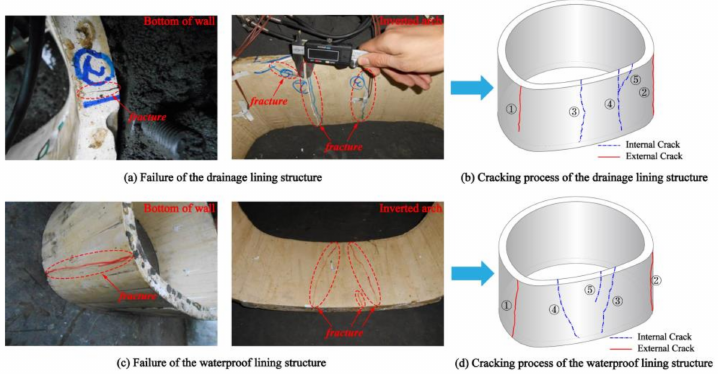
Figure 12. Failure of the lining